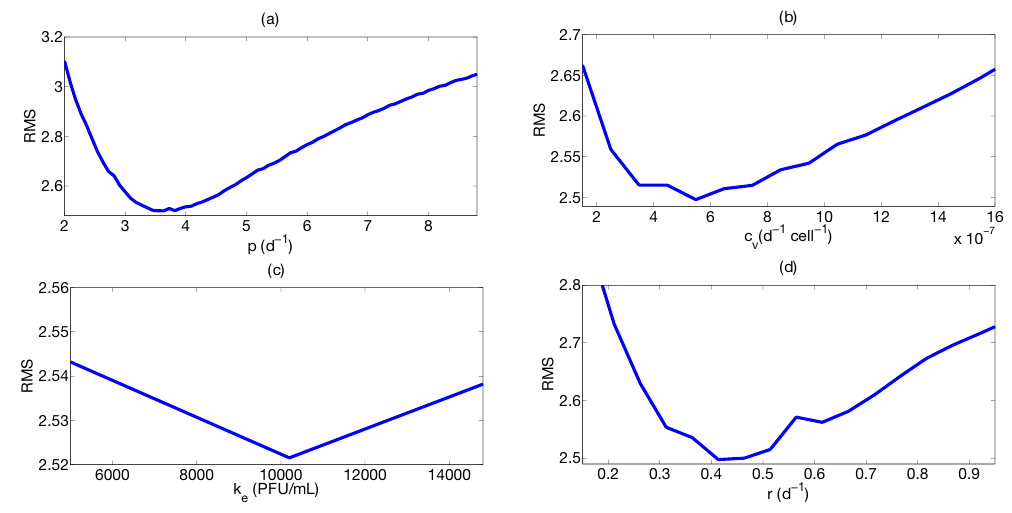
Figure 5. Profile likelihood for the model parameters. ( a ) p is the viral replication rate; ( b ) c v represents the viral clearance; ( c ) k e is the CTLs half saturation constant; ( d ) r represents the CTLs proliferation